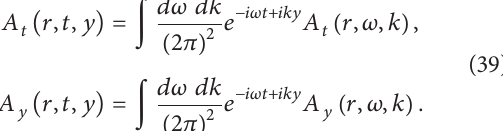
𝜂 2 < 8/(𝐷 − 2) , the free energy at finite temperature is always negative. Therefore, if we do not insert an IR cutoff by